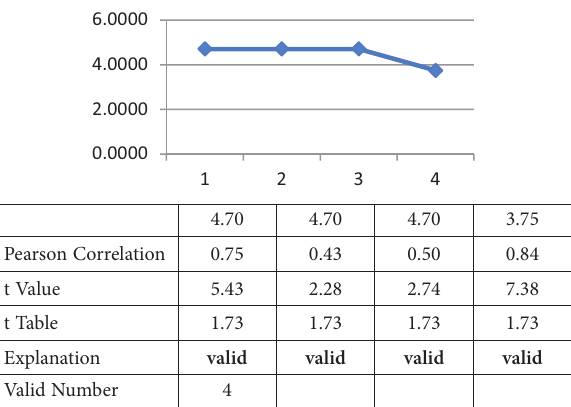
Table 8. Residents’ expectation for the program’s